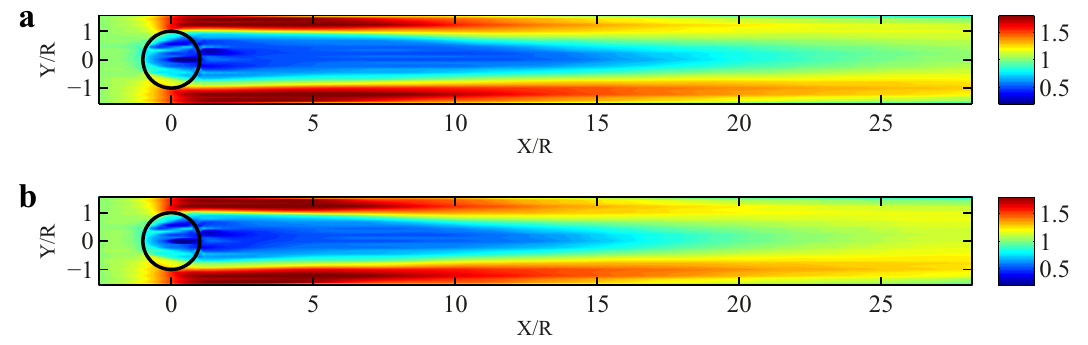
Figure 8. Contours of the normalized mean streamwise velocity, u/U plane at the equator height of the rotor for the actuator swept-surface model (ASSM): ( a ) Smagorinsky model, Cs = 0 . 1 ; ( b ) modulated gradient model (MGM).